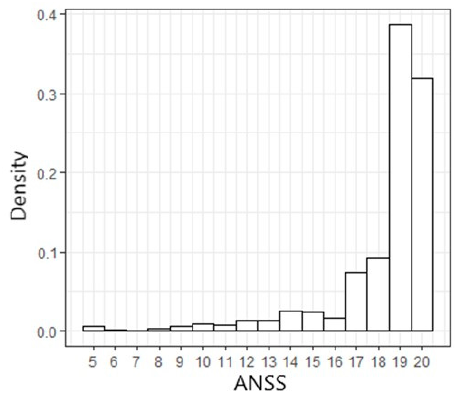
Figure 1. Distribution of admission Norton scale scores in the study population. Table 1. Baseline characteristics by admission Norton scale score.